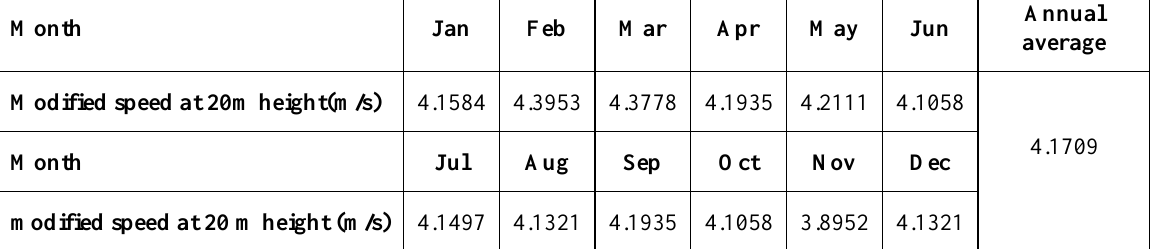
Table 6. Averaged modified wind speed/month for the suggested location